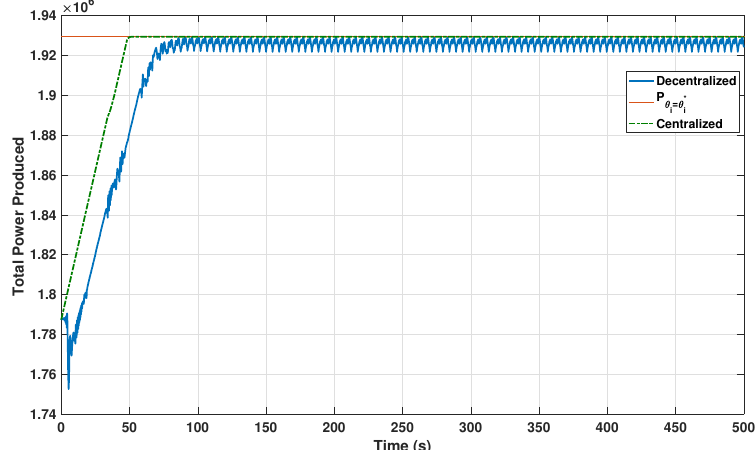
Figure 9. Maximizing the total produced power the proposed method (solid) versus the centralized approach (dotted).